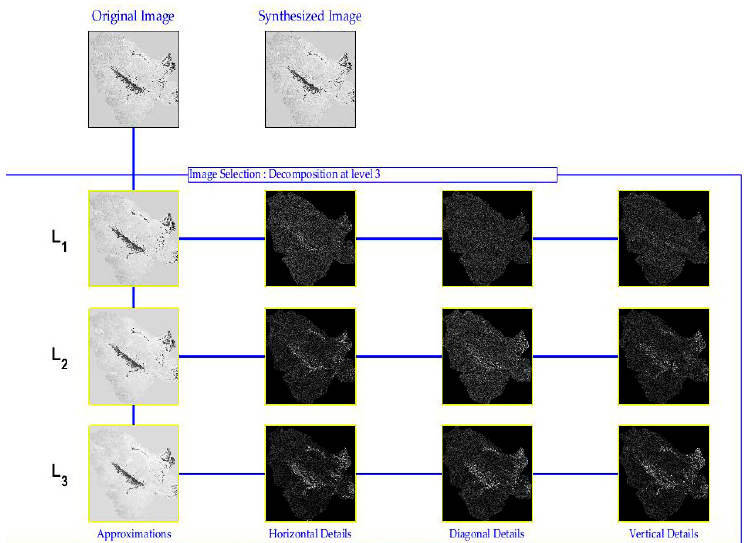
Figure 3. Process of the Coiflect discrete wavelet decomposition for the PC1 of the original Sentinel-2 satellite images. L1–L3 is the decomposition level, and the first column shows the approximation images; the second column shows the images of horizontal details; the third column shows the images of diagonal details and the fourth column shows the images of vertical details .